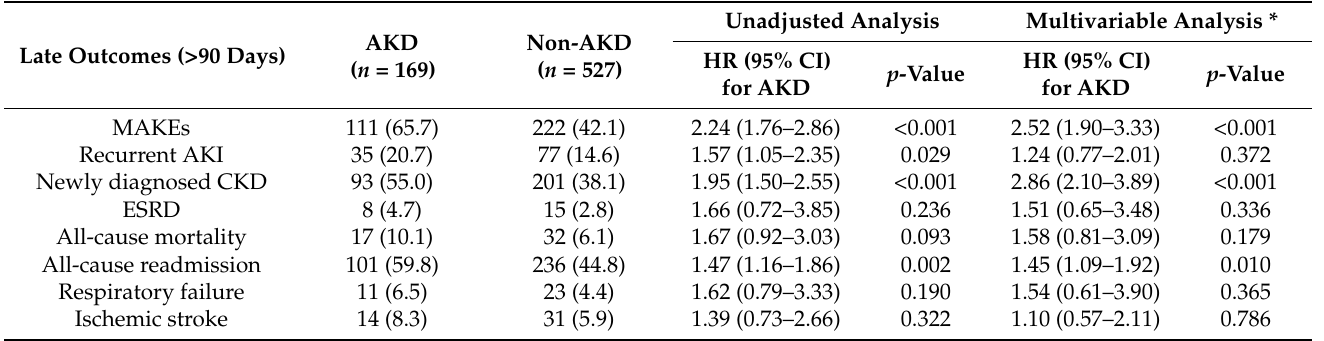
Table 1. Late outcomes during follow-up in the expectation maximization imputation cohort.